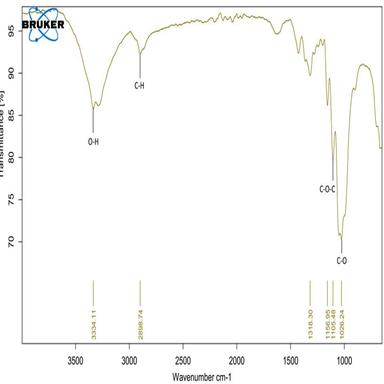
FTIR spectrum of CNC after acid hydrolysis treatment.